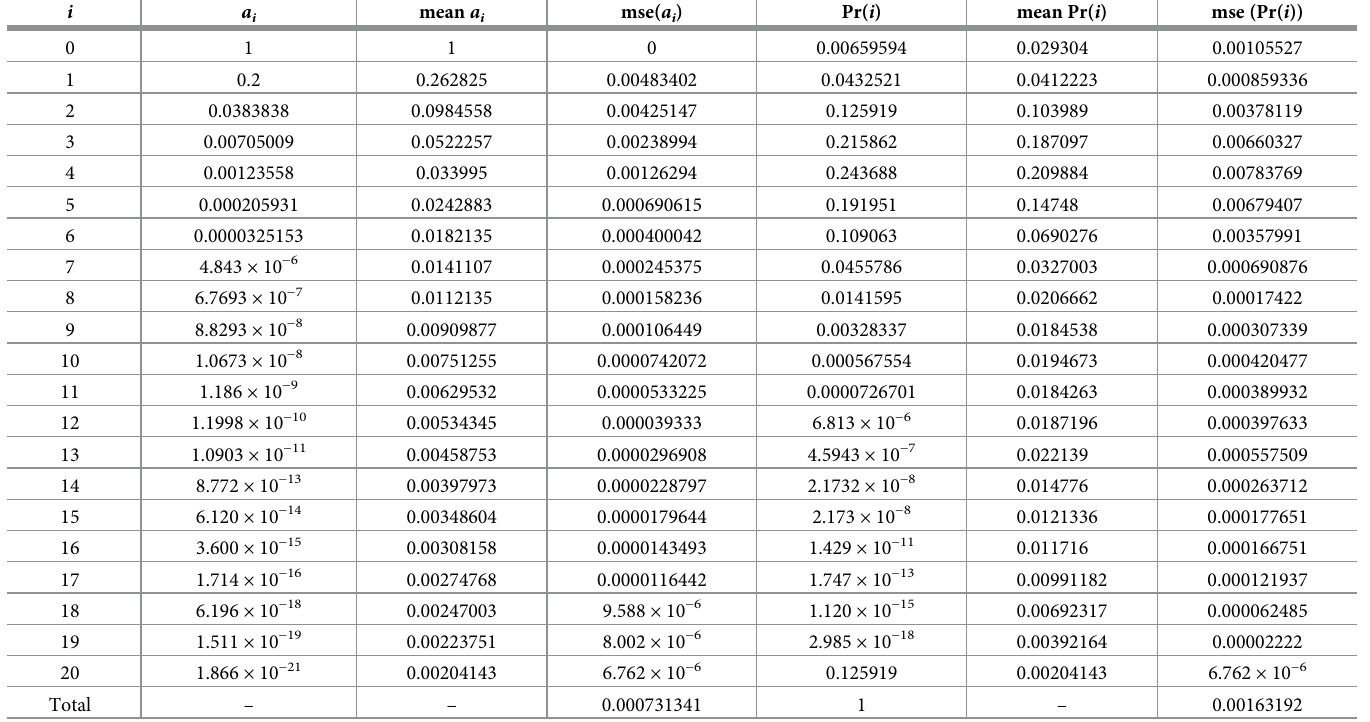
Table 4. Scenario 2. H (100, 20, n ) where n = 5, 10, 20.